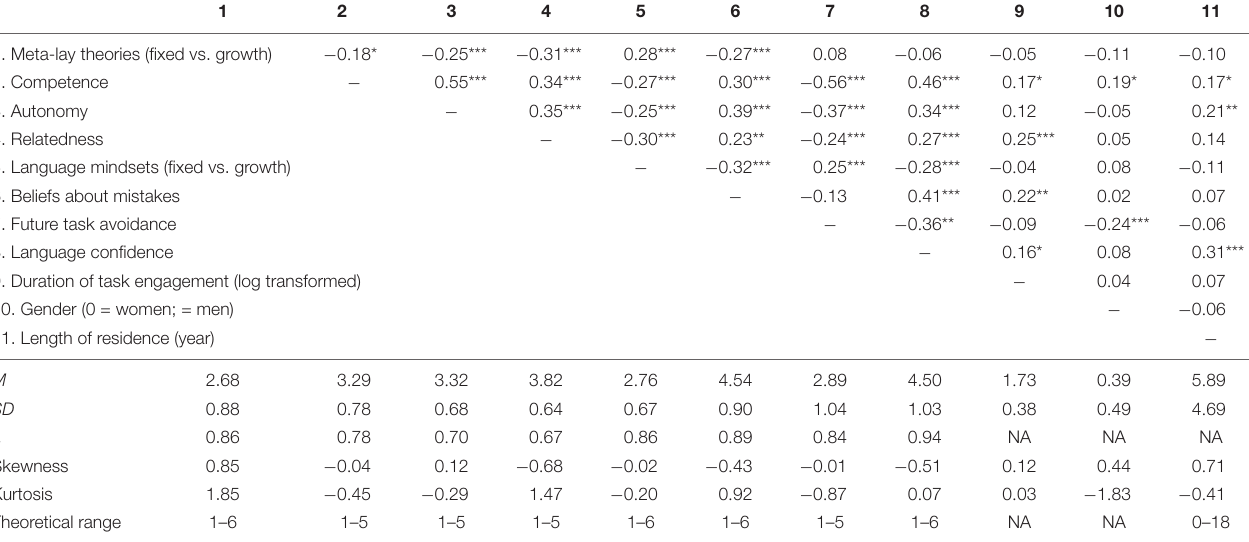
TABLE 1 | Descriptive statistics and correlations among key